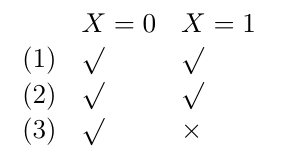
Table 2. Correct/incorrect decisions using three types of data